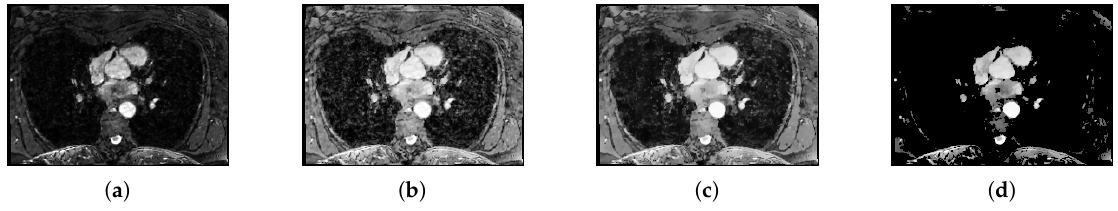
Figure 2. Visualization of the preprocessing pipeline. ( a ) Original image, ( b ) contrast-enhanced image, ( c ) bilateral-filtered image, ( d ) and thresholded